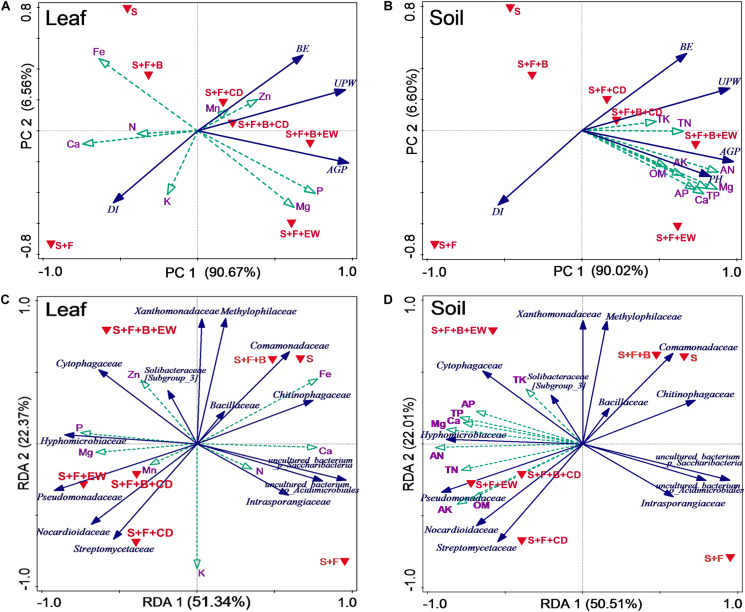
Associations of DI (disease incidence), leaf and soil mineral nutrients, and microbes. Principal component analysis (PCA) based on biocontrol and selected leaves (A) and soil (B) mineral nutrients in the different treatments. Variable included DI (disease incidence), BE (biocontrol efficacy), UPW (belowground weight), AGP (aboveground weight), and PH (pseudo-stem height). Redundancy analysis (RDA) based on the relative abundance of bacterial families and selected leaves (C) and soil (D) mineral nutrients in the different treatments. S, healthy control (healthy soil); S + F, disease control (healthy soil + FOC4); S + F + B, healthy soil + FOC4 + HN03 treatment; S + F + B + EW, healthy soil + FOC4 + HN03 + wormcast treatment; S + F + EW, healthy soil + FOC4 + wormcast treatment; S + F + B + CD, healthy soil + FOC4 + HN03 + cow dung compost treatment; S + F + CD, healthy soil + FOC4 + cow dung compost treatment.